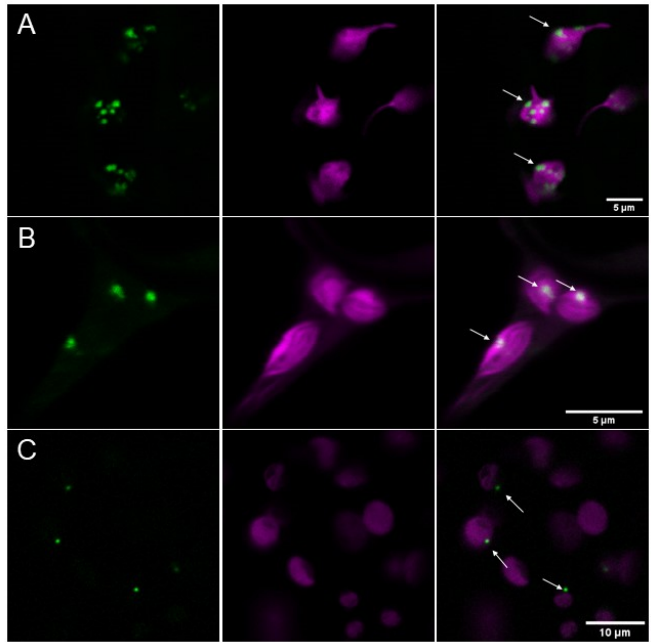
Figure 1. At PII aggregates in focal structures in chloroplasts. ( A ) At PII-GFP (green) under the control of p35S ( p35S CaMV :: At PII cDNA - GFP ) and co-expressed with mCherry-tagged transit peptide of tobacco Rubisco (CD3-999 pt-rk [24]; magenta) localizes to plastids in transiently transformed N. benthamiana 2 days after infiltration. ( B ) Genomic At PII-GFP (green) expressed under the control of the endogenous PII promoter ( pAt PII ::At PII genomic - GFP ) and co-expressed with mCherry-tagged transit peptide of tobacco Rubisco (CD3-999 pt-rk; magenta) localizes to plastids in transiently transformed N. benthamiana 2 days after infiltration. ( C ) Genomic At PII-GFP (green) under the control of endogenous pAt PII ( pAt PII ::At PII genomic - GFP ) localizes to plastids (magenta) in stably transformed A. thaliana . In each row, the GFP fluorescence is shown first, the mCherry fluorescence is shown second, and the merge of both pictures is shown last. White arrows mark exemplarily At PII